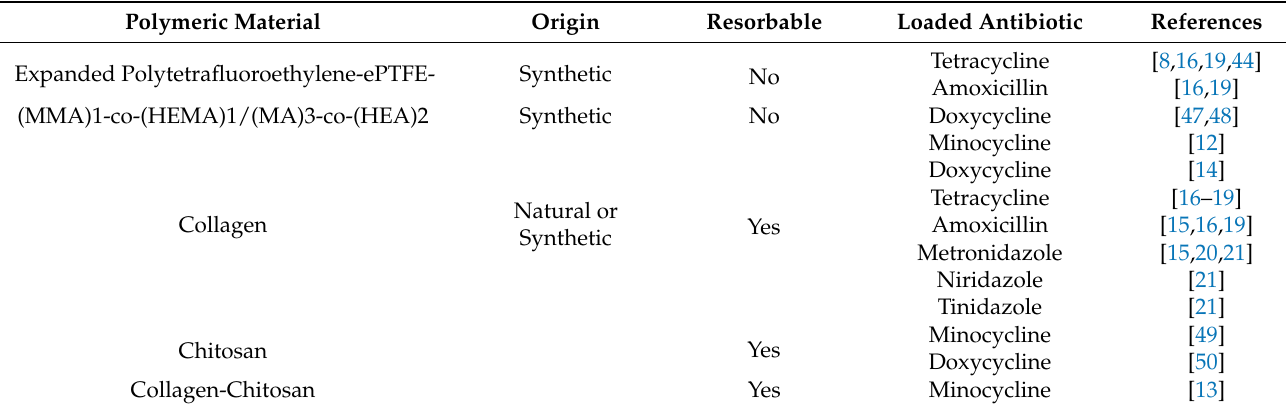
Table 1. Combinations of previously-employed polymers and antibiotics in the designing of barrier membranes for guided bone/tissue